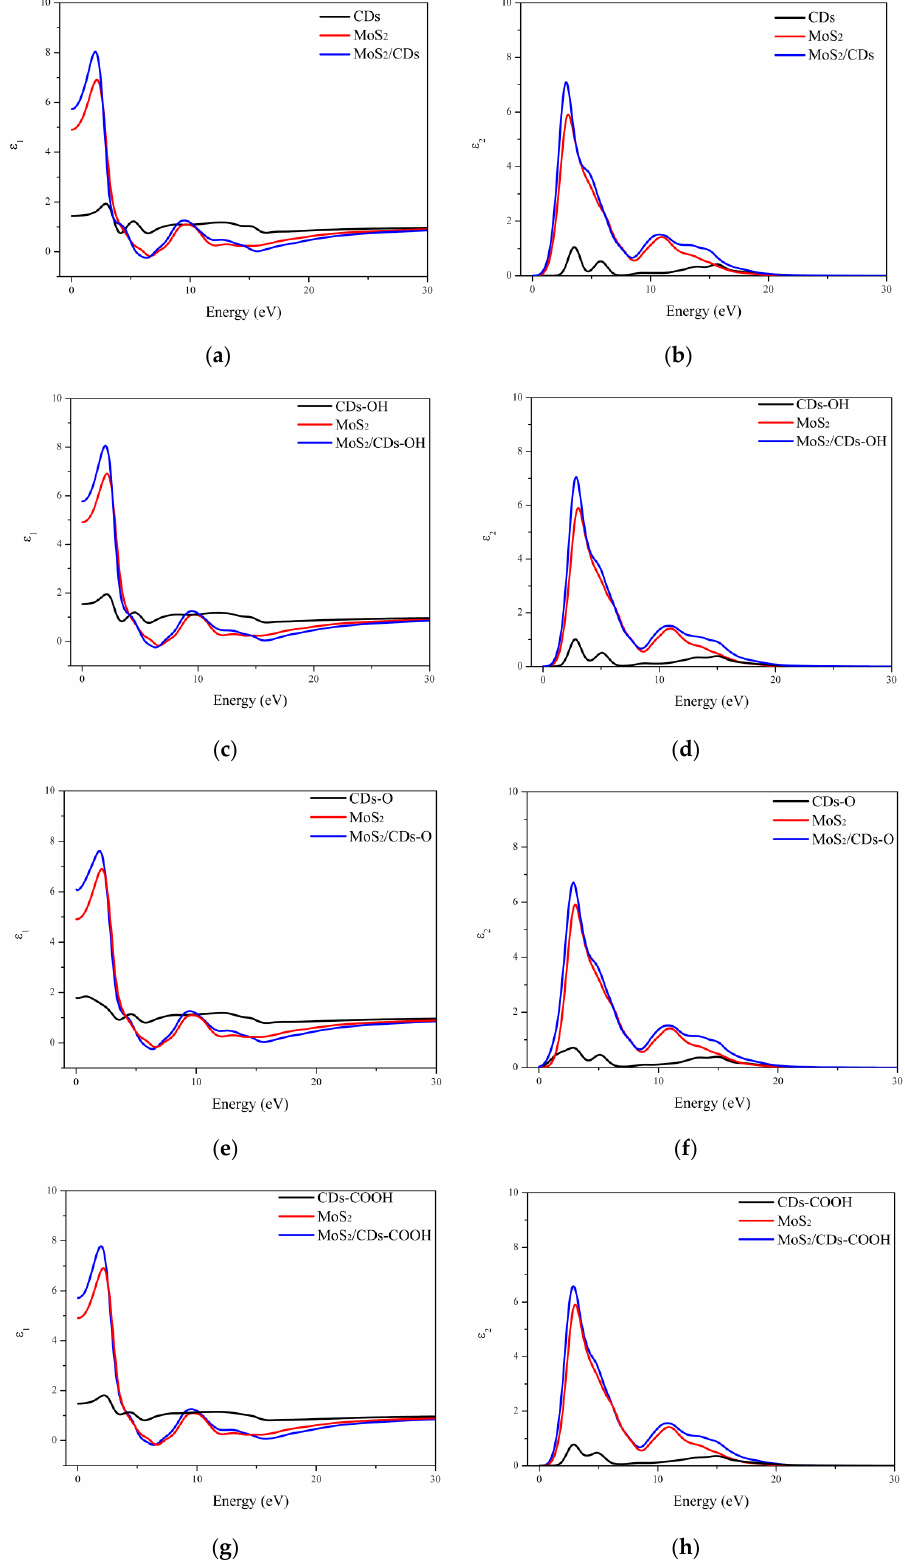
( ) ε ω Figure 5. Real parts, ε 1 ( ω ) of ( a ) MoS 2 /CDs, ( c ) MoS 2 /CDs-OH, ( e ) MoS 2 /CDs-OH, and Figure 5. Real parts, of ( a ) MoS 2 /CDs, ( c ) MoS 2 /CDs-OH, ( e ) MoS 2 /CDs-OH, and ( g ) 1 ( ) ( g ) MoS 2 /CDs-COOH. Imaginary parts, ε 2 ( ω ) of ( b ) MoS 2 /CDs, ( d ) MoS 2 /CDs-OH, ( f ) MoS 2 /CDs- ε ω MoS 2 /CDs-COOH. Imaginary parts, of ( b ) MoS 2 /CDs, ( d ) MoS 2 /CDs-OH, ( f ) MoS 2 /CDs- 2 OH, and ( h ) MoS 2 /CDs-COOH. Imaginary OH, and ( h ) MoS 2 /CDs-COOH. Imaginary parts,.